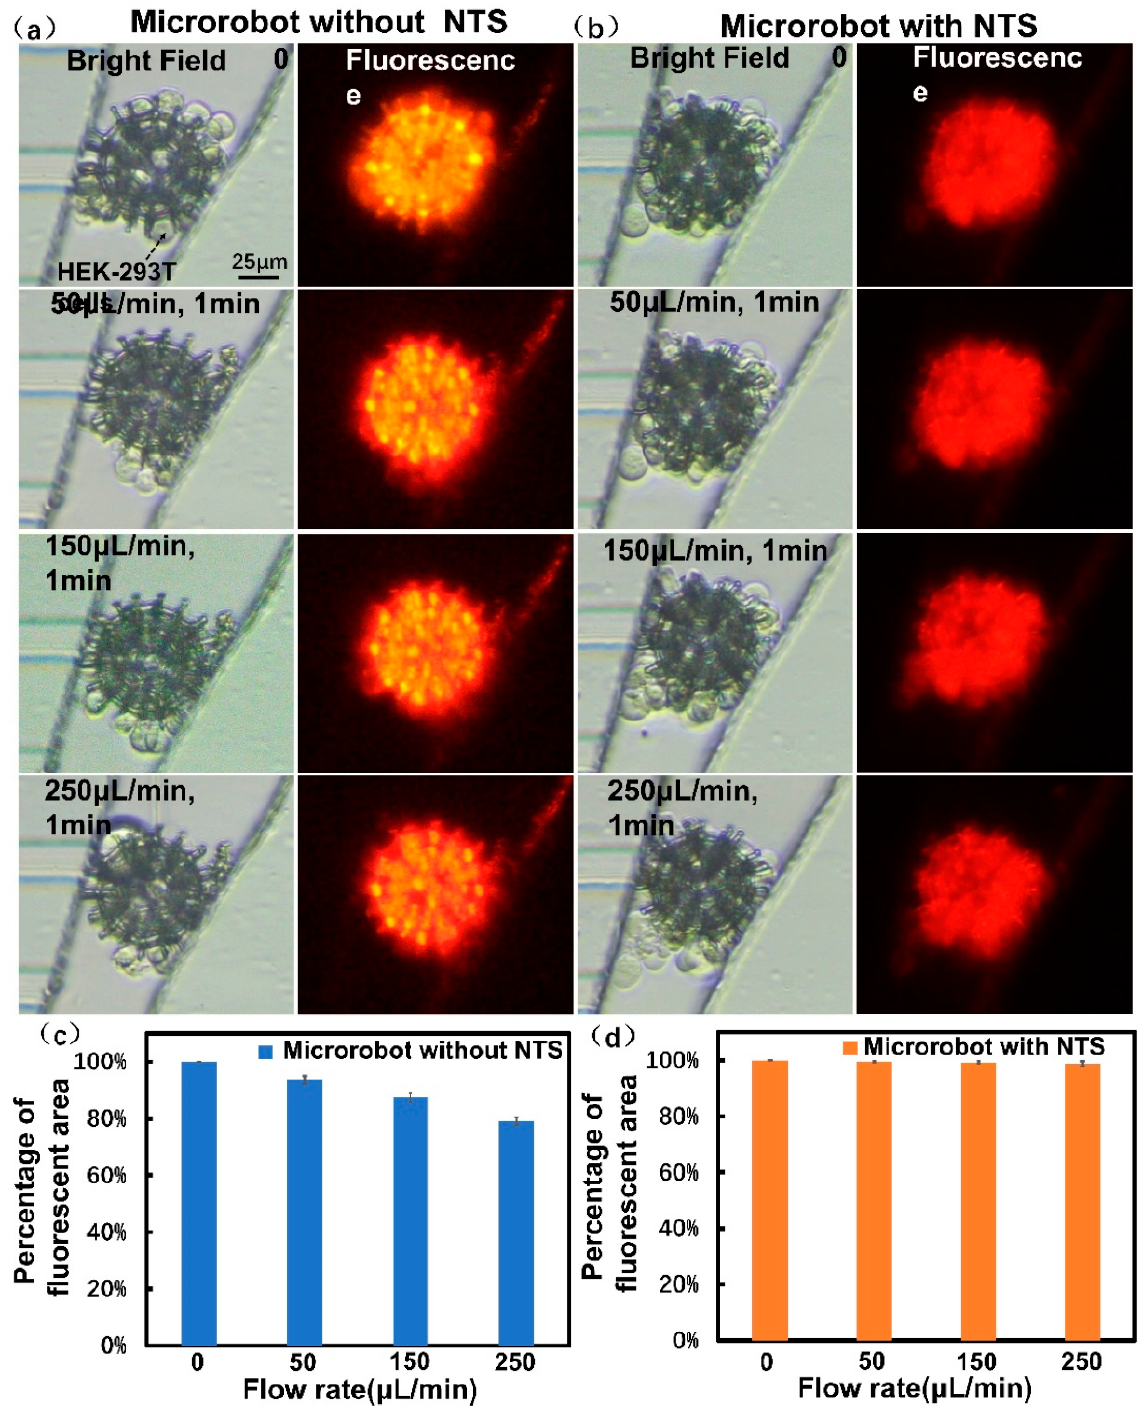
Figure 5. Verification of cell adhesion ability in microfluidic chip: ( a ) HEK-293T cells shed from the microrobot without NTS by passing through different flow rate; ( b ) HEK-293T cells adhered closely to the microrobot with NTS by passing through same volume flow rate; ( c ) The histogram of fluorescent area for microrobot without NTS by passing through different volume flow rate of 50 µ L/min, 150 µ L/min and 250 µ L/min in one minute (n = 3); ( d ) The histogram of fluorescent area for microrobot with NTS by passing through different volume flow rate of 50 µ L/min, 150 µ L/min and 250 µ L/min in one minute (n = 3). Error bars indicate SD.